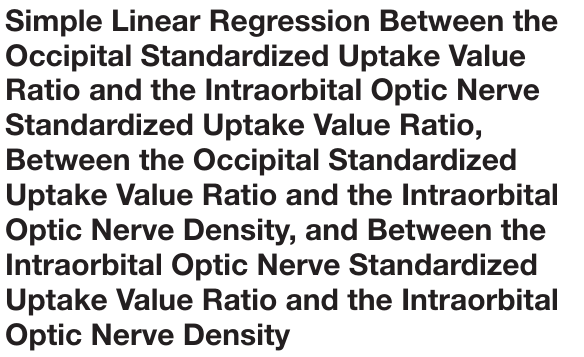
Simple linear regression was used with the entire sample between occipital SUVR and intraorbital optic nerve SUVR,